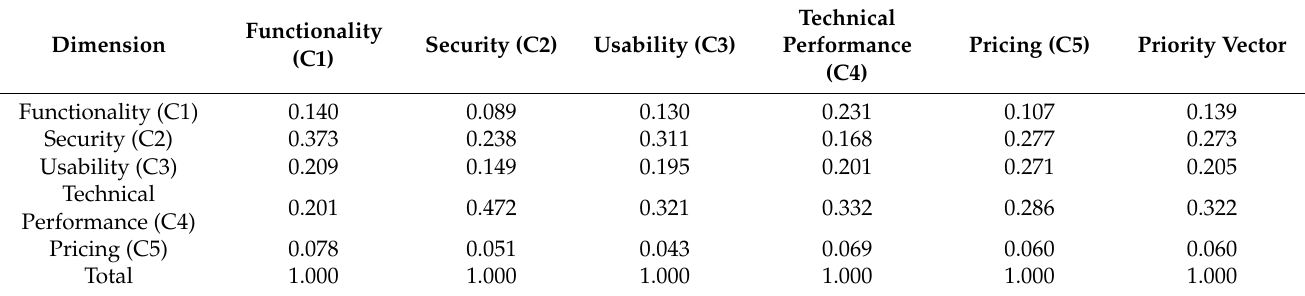
Table 7. The normalized matrix of